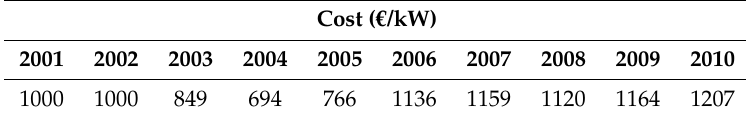
Table 4. Average capital cost for onshore wind power systems in Greece from 2003 to 2010. Note here that for the year 2009, the original number in the report was “1628”; however, it is regarded as a skewed result.